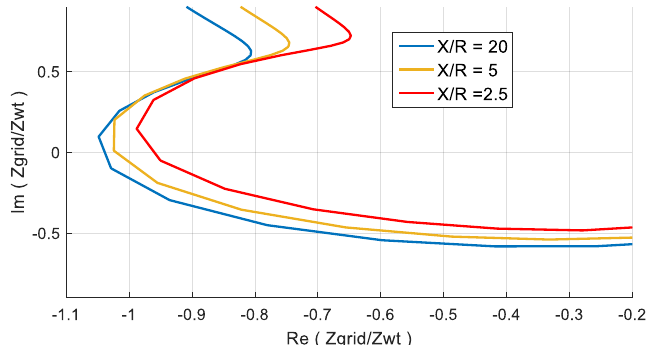
Figure 10. Nyquist criteria under X g /R variations for SCR = 1.25 and X c /X g = 0. Table 3. Poles for X c /X g variations for SCR = 1.25 and X g /R = 20.